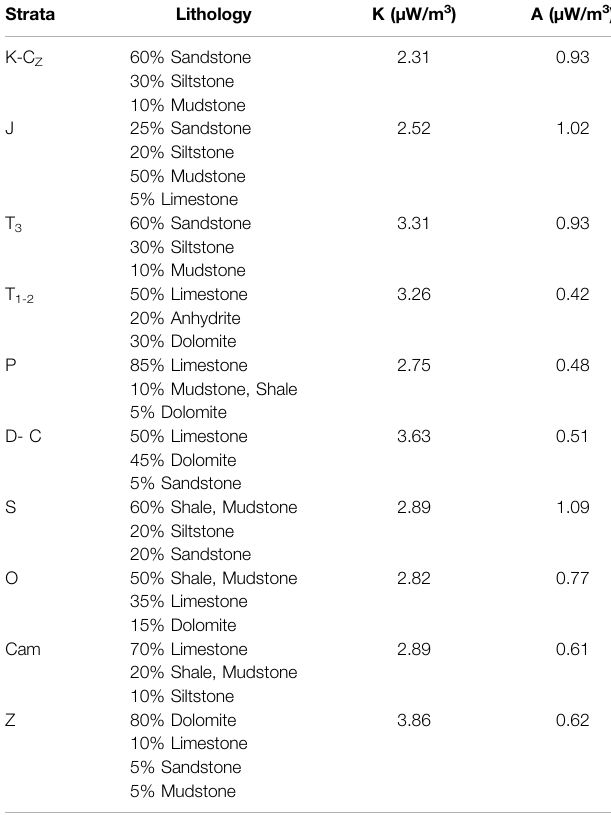
TABLE 1 | The lithology composition and the thermal conductivity (K) and heat production rate (A) of sedimentary layers in the Sichuan Basin a .